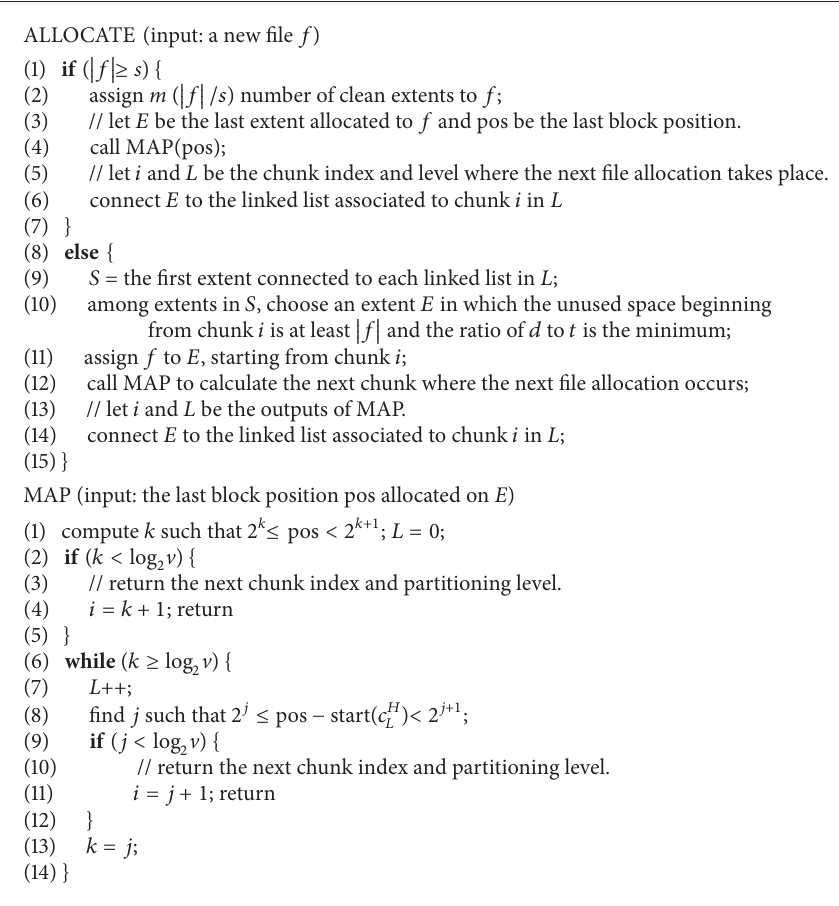
Algorithm 1: The procedure for the file allocation in